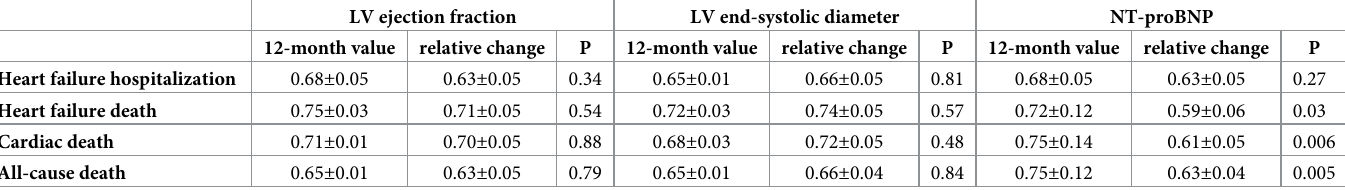
Table 5. Receiver-operating characteristics: Comparison of areas under the